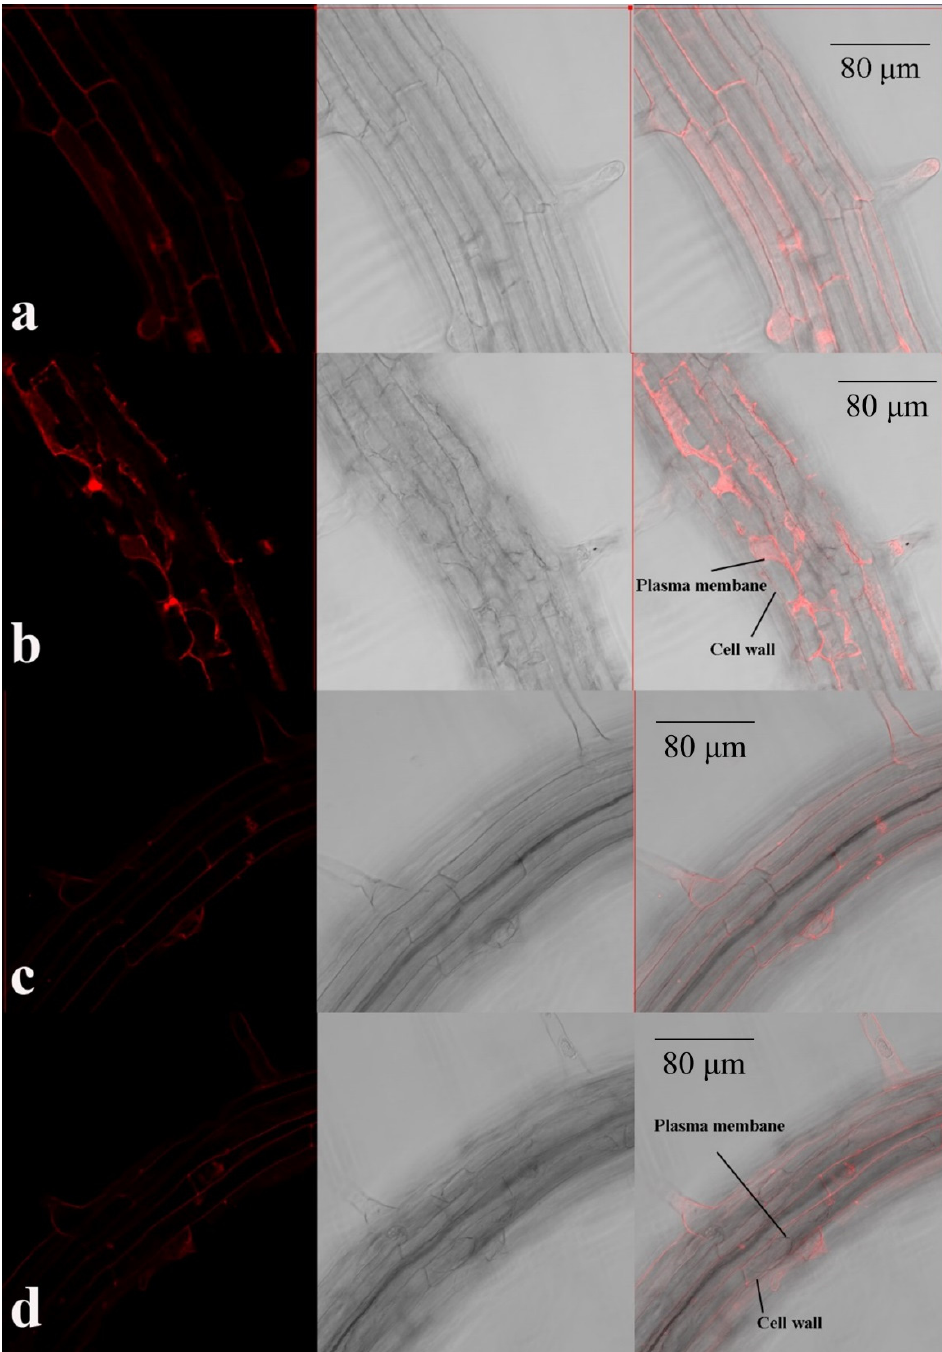
Figure 6. Subcellular localization of AtPDF1.5 in roots. ( a ) 35S::mRFP before sucrose treatment. ( b ) 35S::mRFP after sucrose treatment. ( c ) 35S::AtPDF1.5-mRFP before sucrose treatment. ( d ) 35S::AtPDF1.5-mRFP after sucrose treatment.